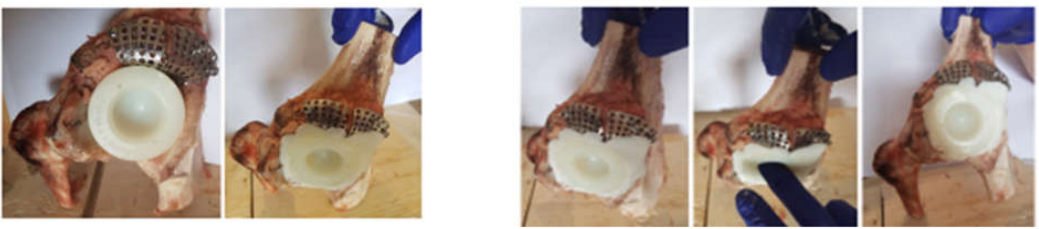
Figure 13. Final model of the orthopaedic prosthesis with morcellated bone graft and reconstructive mesh.